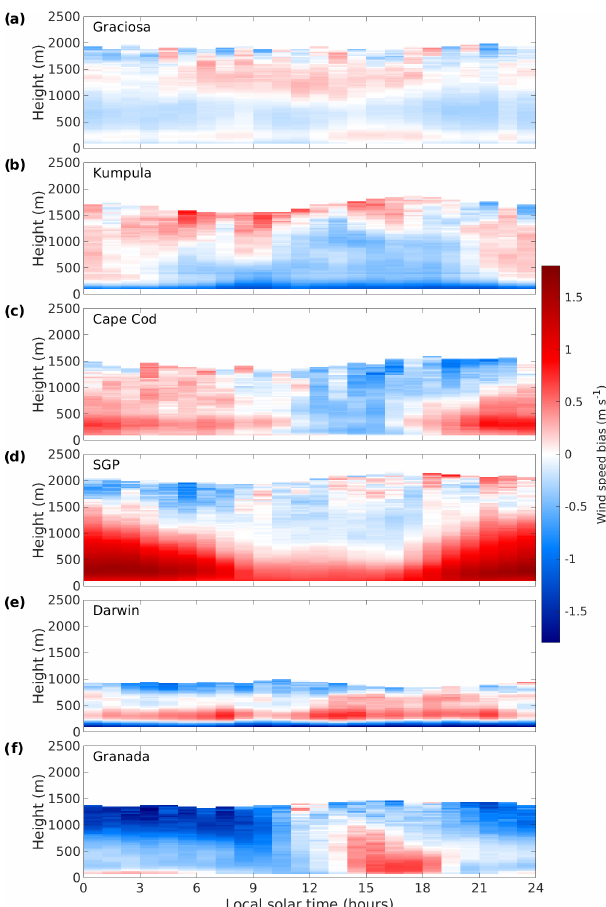
Figure 8. Diurnal composites of wind speed bias at (a) Graciosa, (b) Kumpula, (c) Cape Cod, (d) SGP, (e) Darwin, and (f) Granada. Time refers to approximate local solar time.